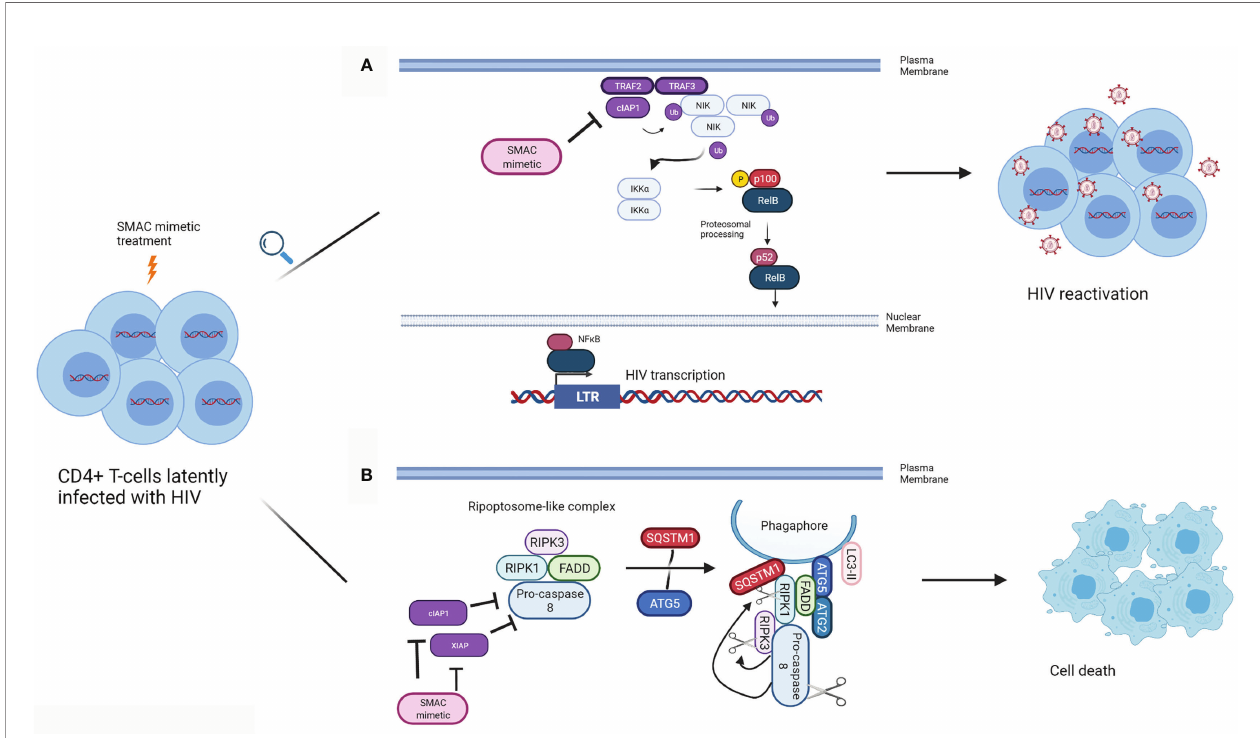
FIGURE 1 | Mechanism of action of SMAC mimetics in latency reversal and apoptosis. (A) SMAC mimetics can induce latency reversal in HIV infected cells. TRAF2 and TRAF3 recruit NIK to cIAP1, and cIAP1 ubiquitinates NIK, resulting in its proteosomal degradation, preventing non-canonical NF k B signalling. SMAC mimetics bind to the BIR3 domain of cIAP1, which results in cIAP1 ’ s autoubiquitination and degradation, freeing NIK. NIK accumulates in the cytoplasm, and activates IKK a , which in turn phosphorylates p100. p100 undergoes proteosomal processing to form p52, and the RelB/p52 NF k B complex translocates into the nucleus. NF k B can then bind to the LTR to inducing HIV gene expression leading to latency reversal. (B) SMAC mimetics can lead to apoptosis of HIV infected cells. SMAC mimetics cause the degradation of cIAP1 and XIAP, resulting in autophagy induction in HIV infected T CM. A ripoptosome-like DISC complex (Caspase 8, RIPK1, RIPK3, FADD), forms on unclosed phagophore membranes by using autophagy machinery (SQSTM1, ATG5, ATG2, LC3-II) as a scaffold, leading to selective killing of HIV infected CD4 + T CM . (Adapted from 63). (Created with